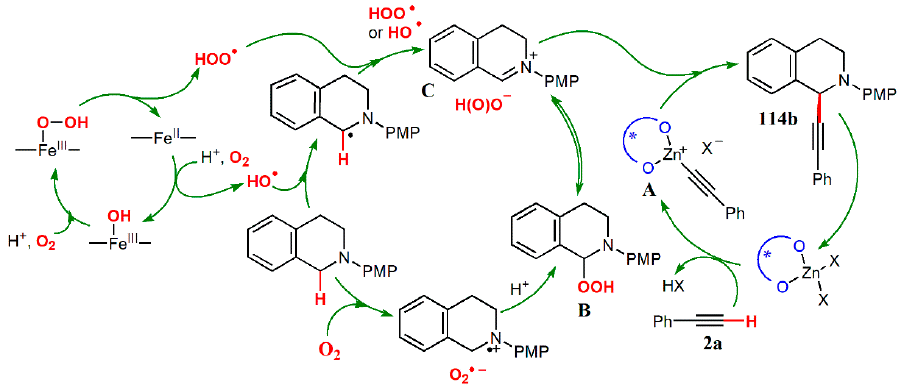
Figure 44. The mechanism proposed for the enantioselective CDC of THIQs with alkynes by Zn–Fe activation.